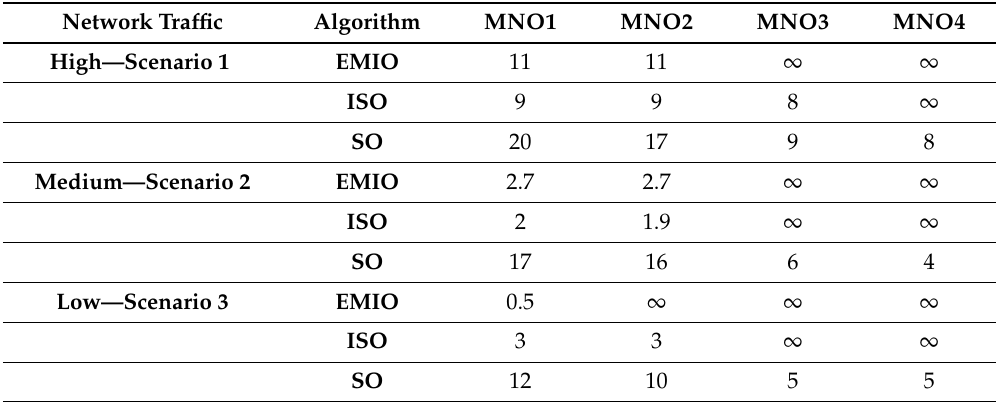
Table 1. Operator energy savings (%) with respect to the FOT scheme. Network Traffic